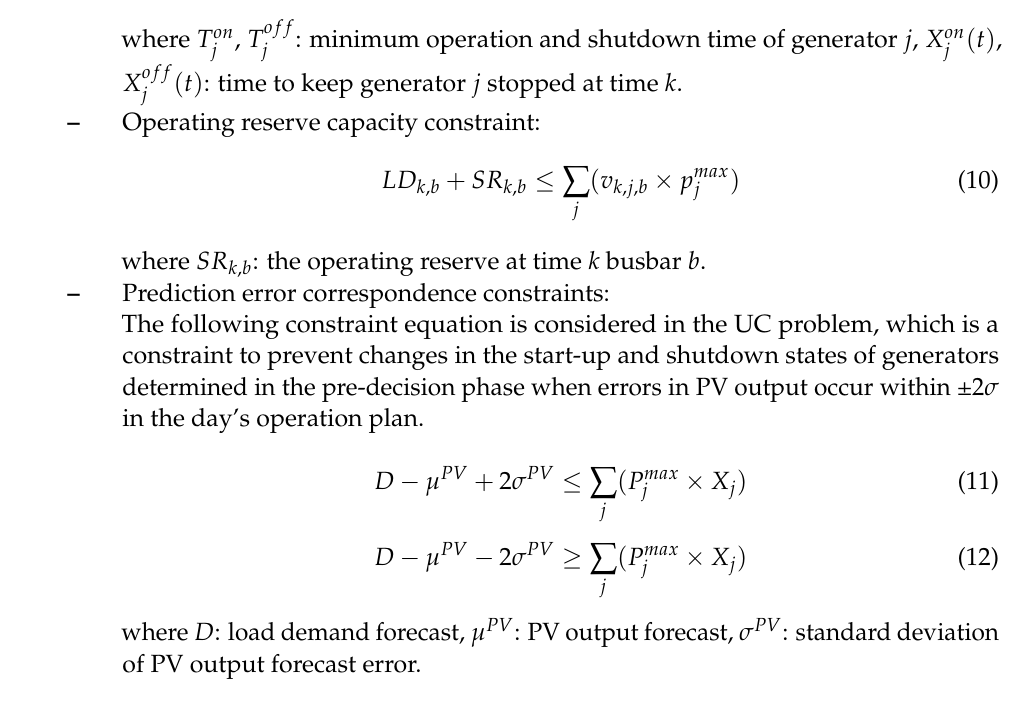
Table 2. Generator’s parameters.